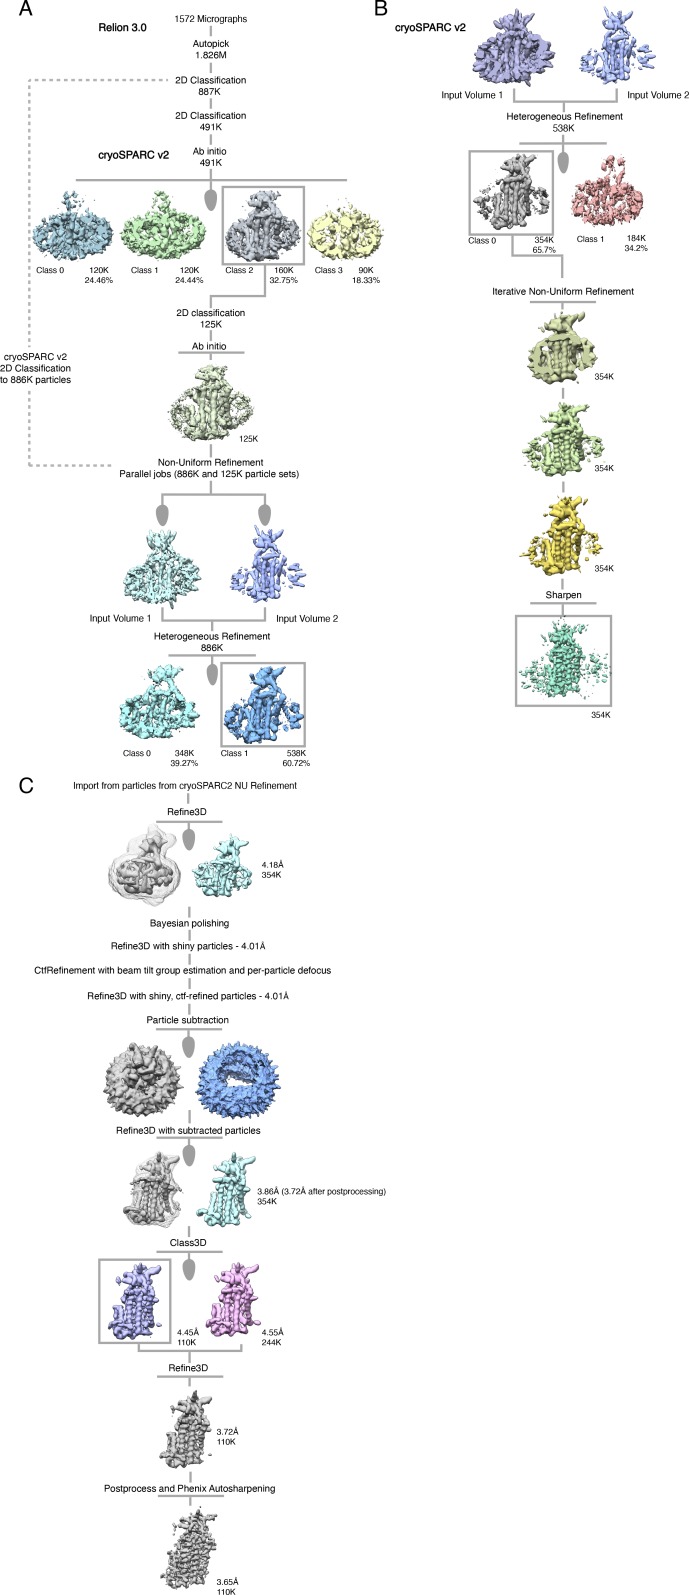
Cryo-EM processing pipeline for KCC4 in MSP1D1 nanodiscs.(A, B) Initial stages of cryo-EM data processing in Relion and cryoSPARC2. (C) Final stages of cryo-EM data processing in Relion. See Materials and methods for details.